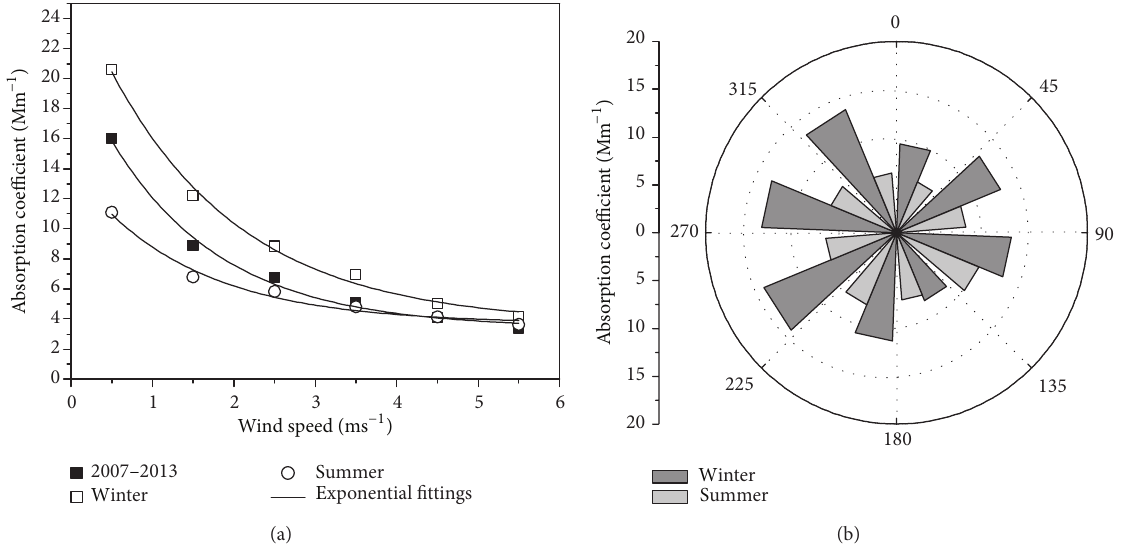
Figure 5: Dependence of the absorption coefficient on (a) the wind speed and (b) direction for summer and winter seasons.